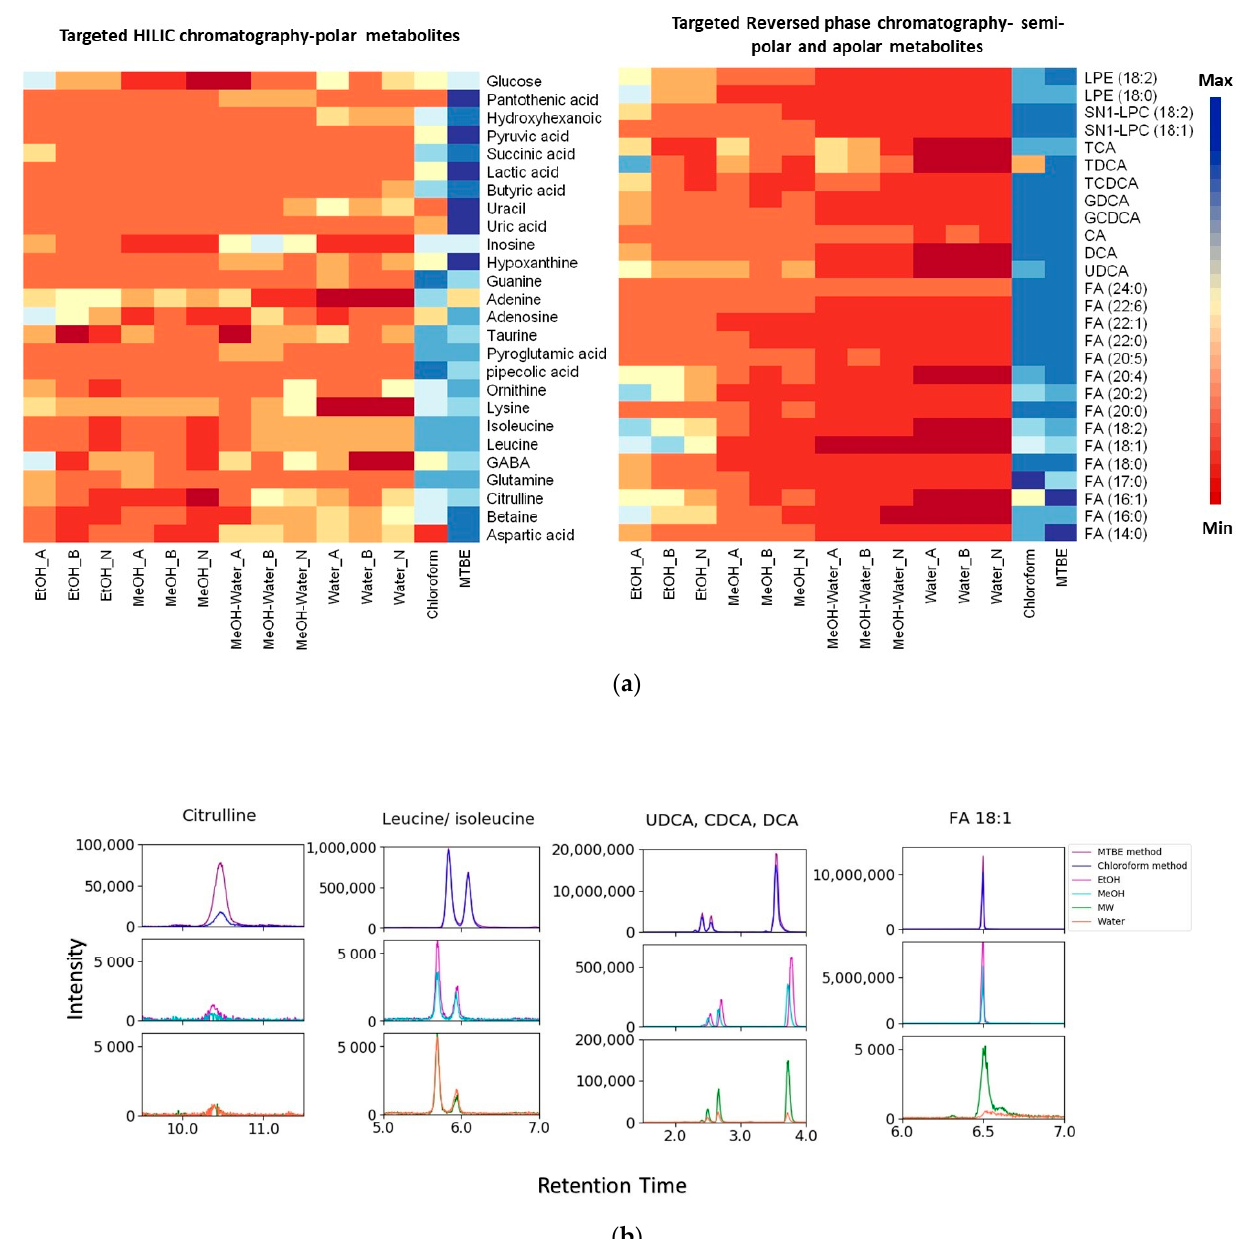
Figure 3. The effect of the extraction solvent system on the extraction efficiency. ( a ) Heatmap of the peak area of the metabolites from different classes of compounds using single-phase (first cycle of extractions with different solvents and pH values) and two-phase liquid–liquid extraction (MTBE and chloroform methods). Dark blue and dark red colors represent the largest and smallest peak area, respectively. ( b ) Peak shapes and intensity of metabolites extracted with different extraction solvents in neutral pH. -A: acidic, -B: basic, -N: neutral. FA: fatty acid; UDCA: ursodeoxycholic acid; CDCA: chenodeoxycholic acid; DCA: deoxycholic acid.